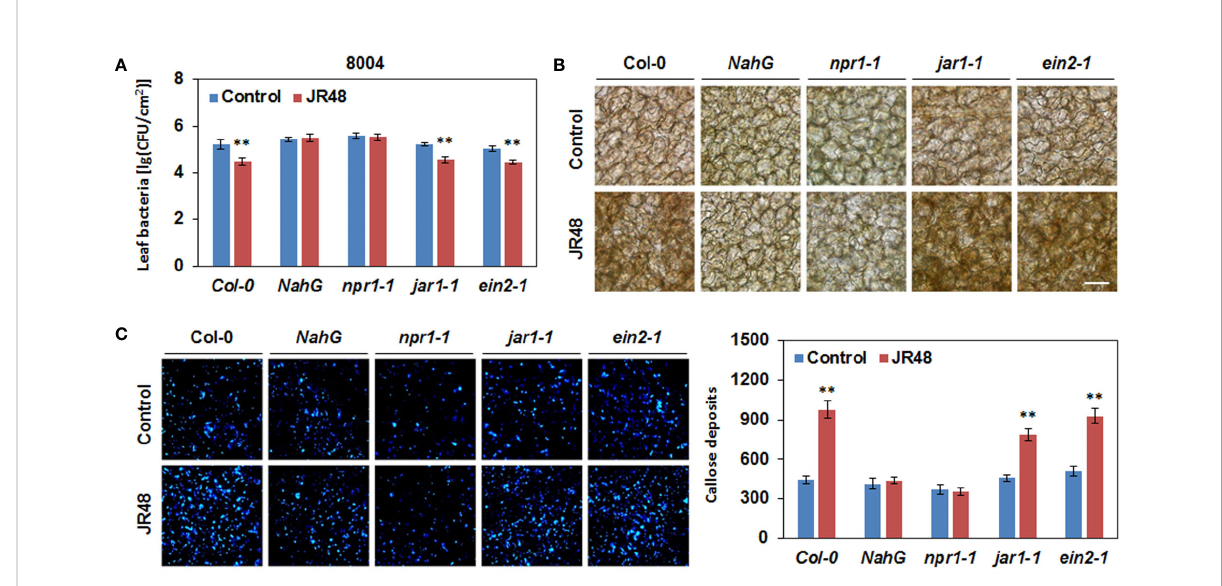
FIGURE 6 JR48-induced plant resistance and defense responses in Arabidopsis of different genotypes. (A) Bacterial growth assay on Arabidopsis leaves. Suspensions of Xcc 8004 were in fi ltrated into leaves of Col-0, NahG , npr1-1 , jar1-1 , and ein2-1 plants pre-treated with sterile water (control) or JR48. Bacterial population was measured at 3 dpi. Values are presented as mean ± SD (n (number of leaves) ≥ 6) representative of three independent biological replicates. Student ’ s t -test was used to determine signi fi cant differences between Control and JR48 (**P < 0.01). (B) H 2 O 2 accumulation during pathogen infection. Leaves of pre-treated Arabidopsis Col-0, NahG , npr1-1 , jar1-1 , and ein2-1 plants were in fi ltrated with Xcc 8004. DAB staining was performed at 12 hpi. Scale bar, 60 m m. (C) Callose deposition during pathogen infection. Pre-treated Arabidopsis of different genotypes were inoculated with Xcc 8004. Leaves were detached for callose staining at 12 hpi. Representative images were photographed and numbers of callose deposition were calculated (mean ± SD; n (number of leaves) ≥ 8; **P < 0.01, Student ’ s t -test). This experiment was repeated three times with similar